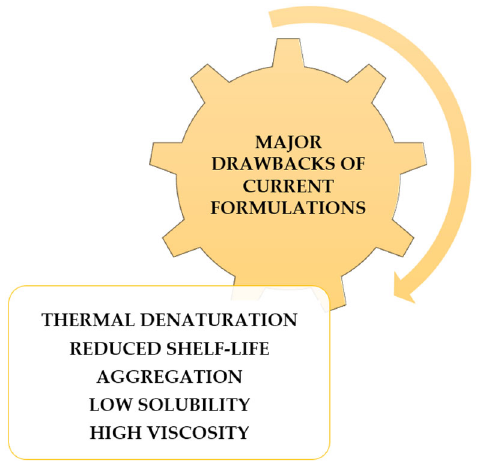
Figure 1. Main drawbacks of current protein formulations.